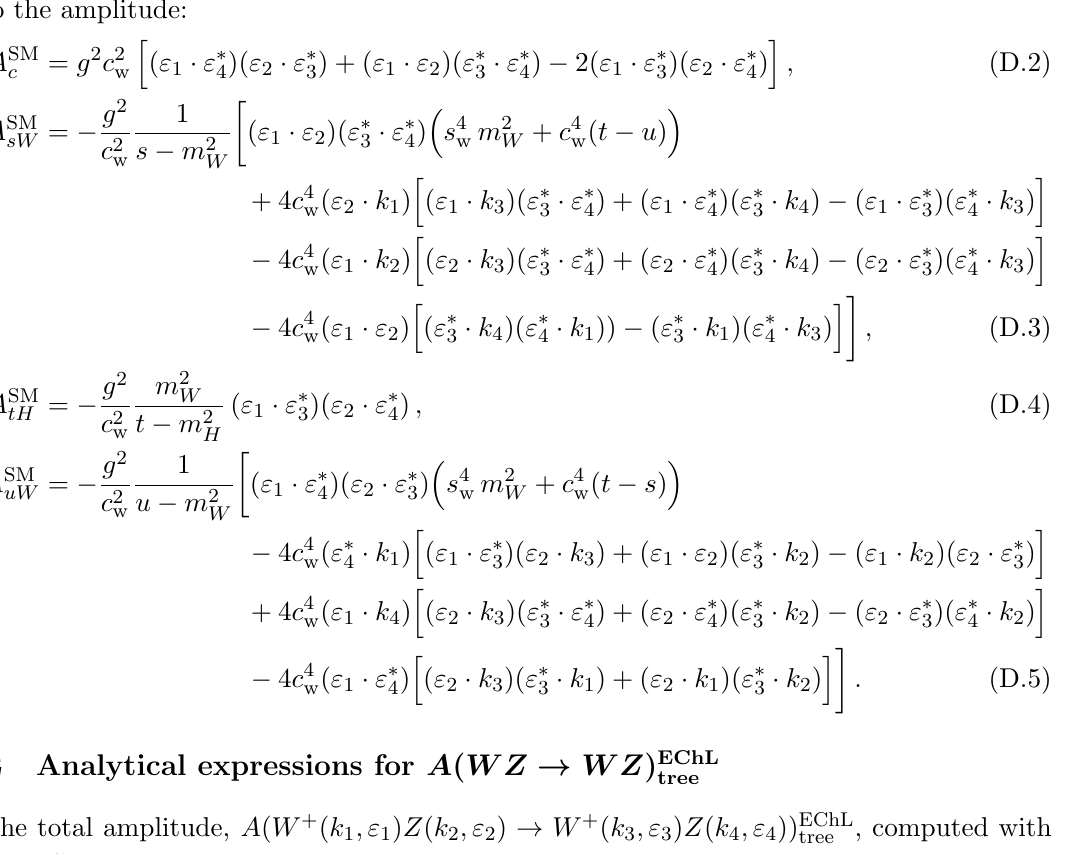
Figure 21 . Feynman diagrams that contribute to the A ( WZ the tree level and in the unitary